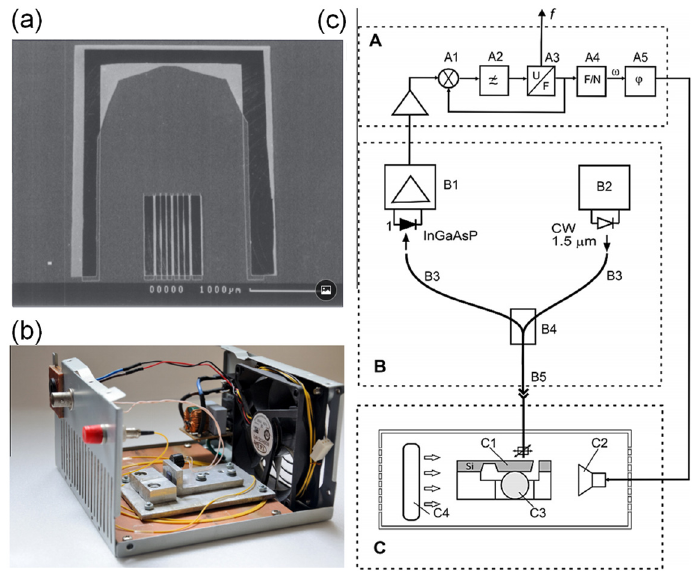
Figure 21. Point sensor. ( a ) SEM image of the sensor head. ( b ) Photograph of the sensing system. ( c ) Experimental setup. Reprinted with permission from [98] © Elsevier .